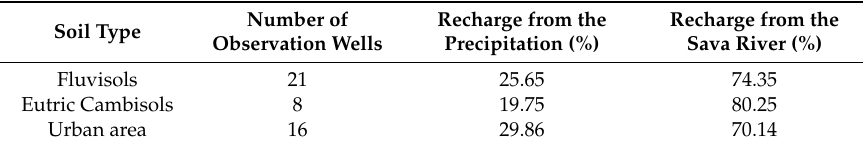
Table 5. Average recharge in di ff erent soil types in the area of the Zagreb aquifer.